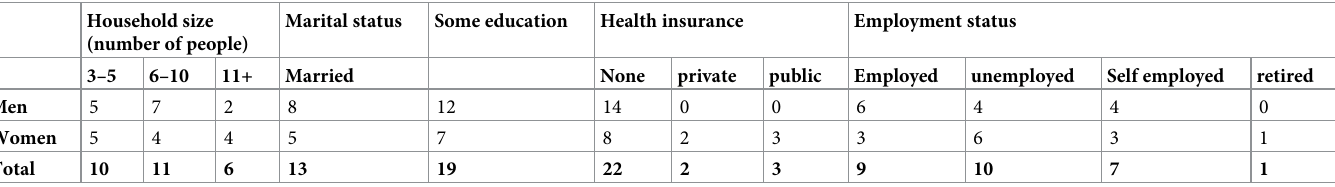
Table 2. Distribution of participants based on social factors of household size, marital status, access to insurance, employment status and level of education. Household size (number of